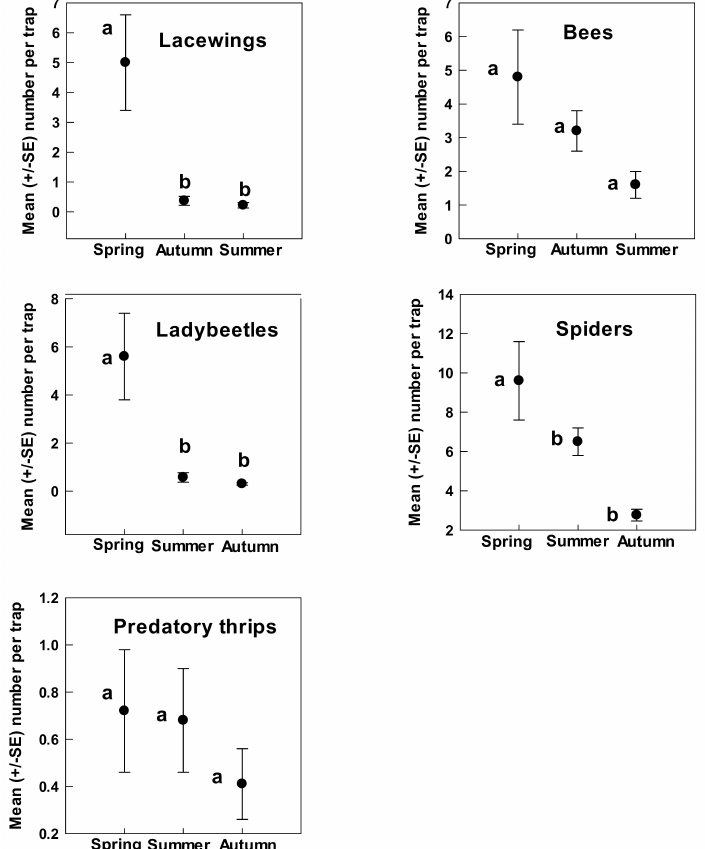
Figure 4. Beneficial arthropods associated with A. tridentata that showed greatest abundance during spring. Different letters denote significant differences ( p <